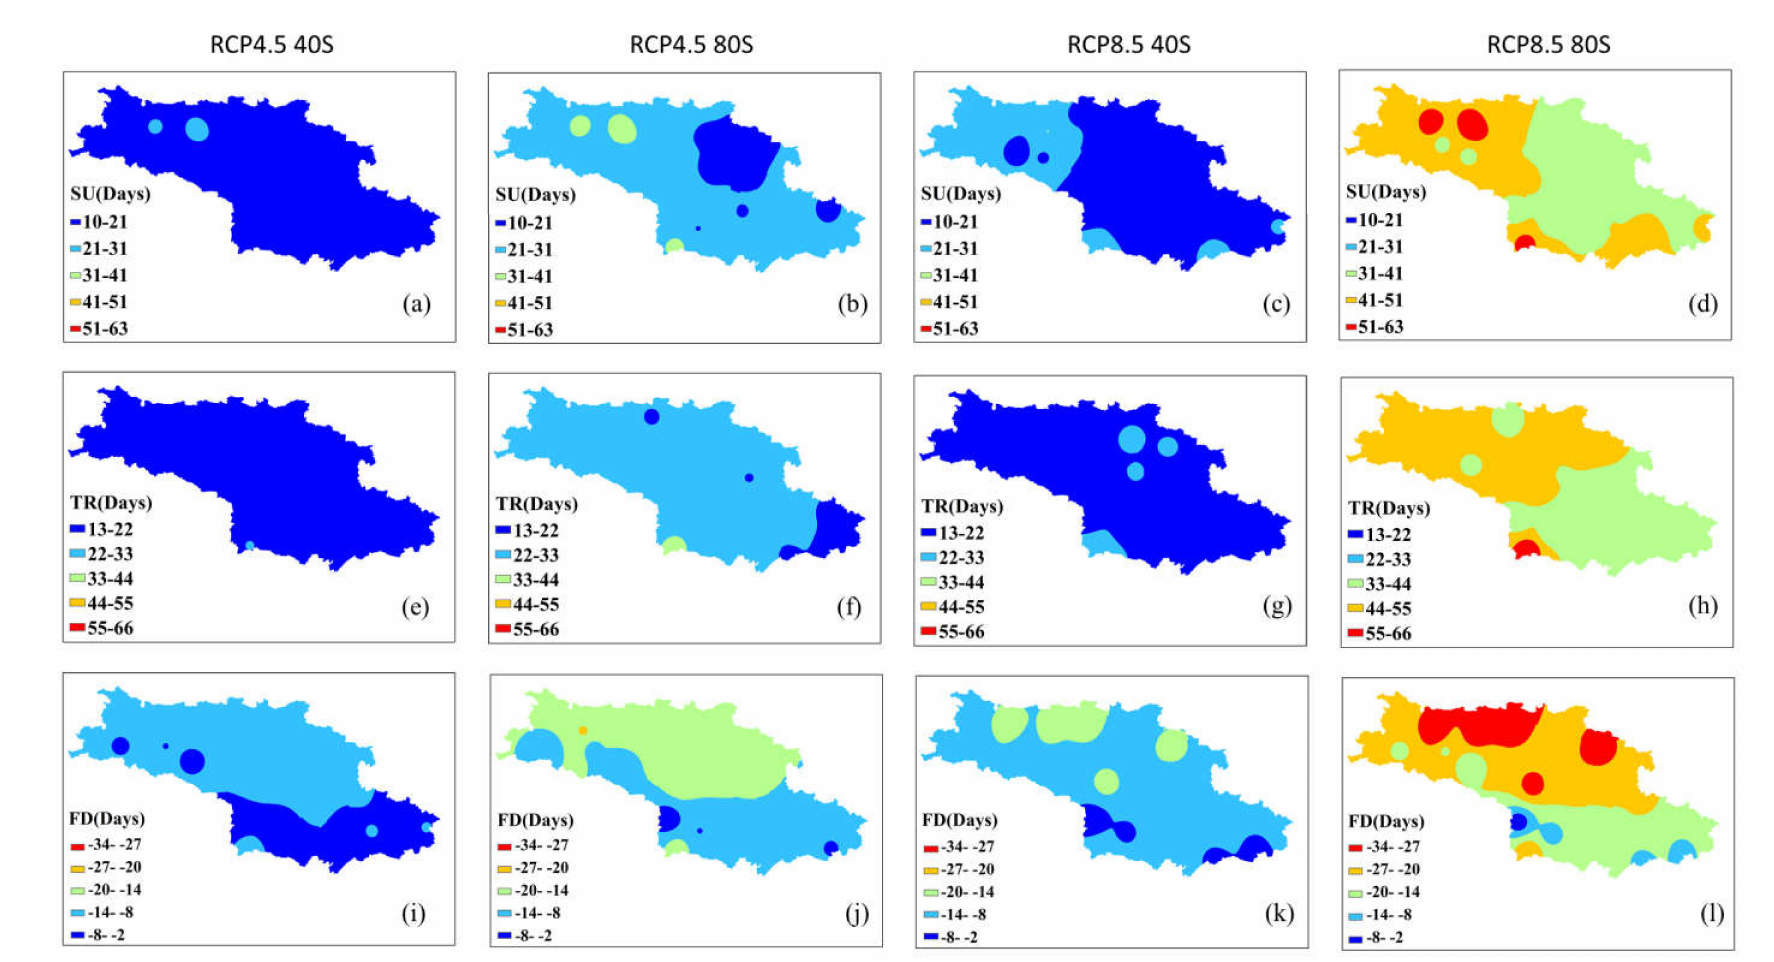
Figure 6. The spatial distribution of changes in the multi-model ensemble for the three fixed threshold-based indices (SU, a – d ; TR, e – h ; FD, i – l ) during 2021–2100 under two scenarios relative to 1961–2013 across the Han River Basin